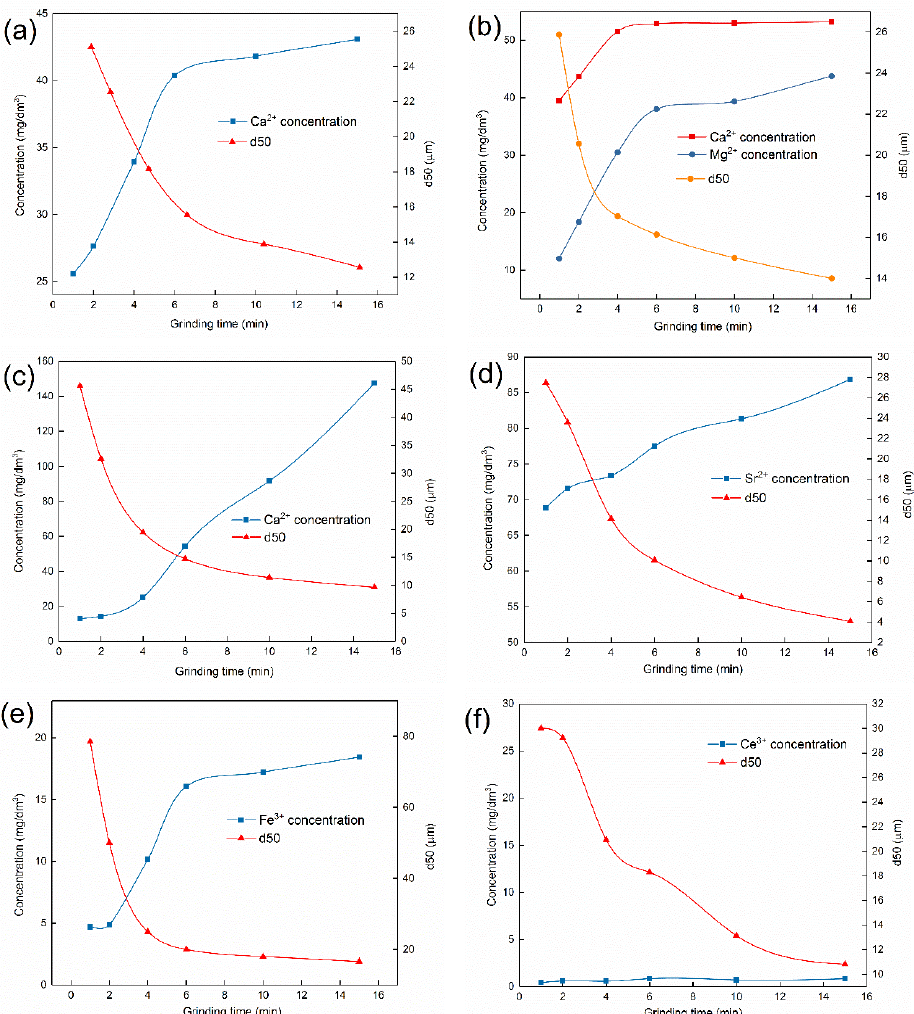
Figure 3. Concentration of metal ions release from minerals.